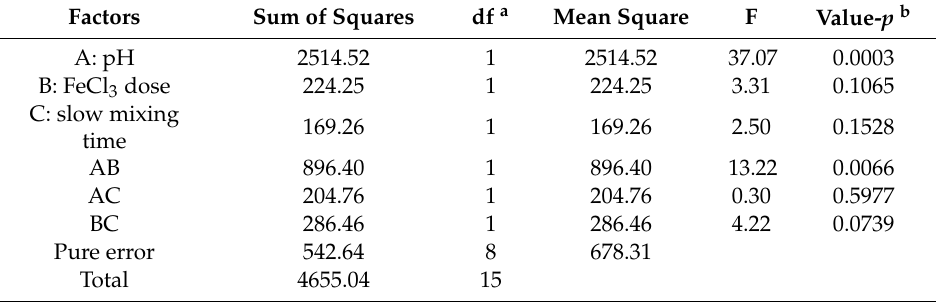
Table 4. ANOVA results for coagulation / sedimentation experiment with FeCl 3 · 6H 2 O coagulant.